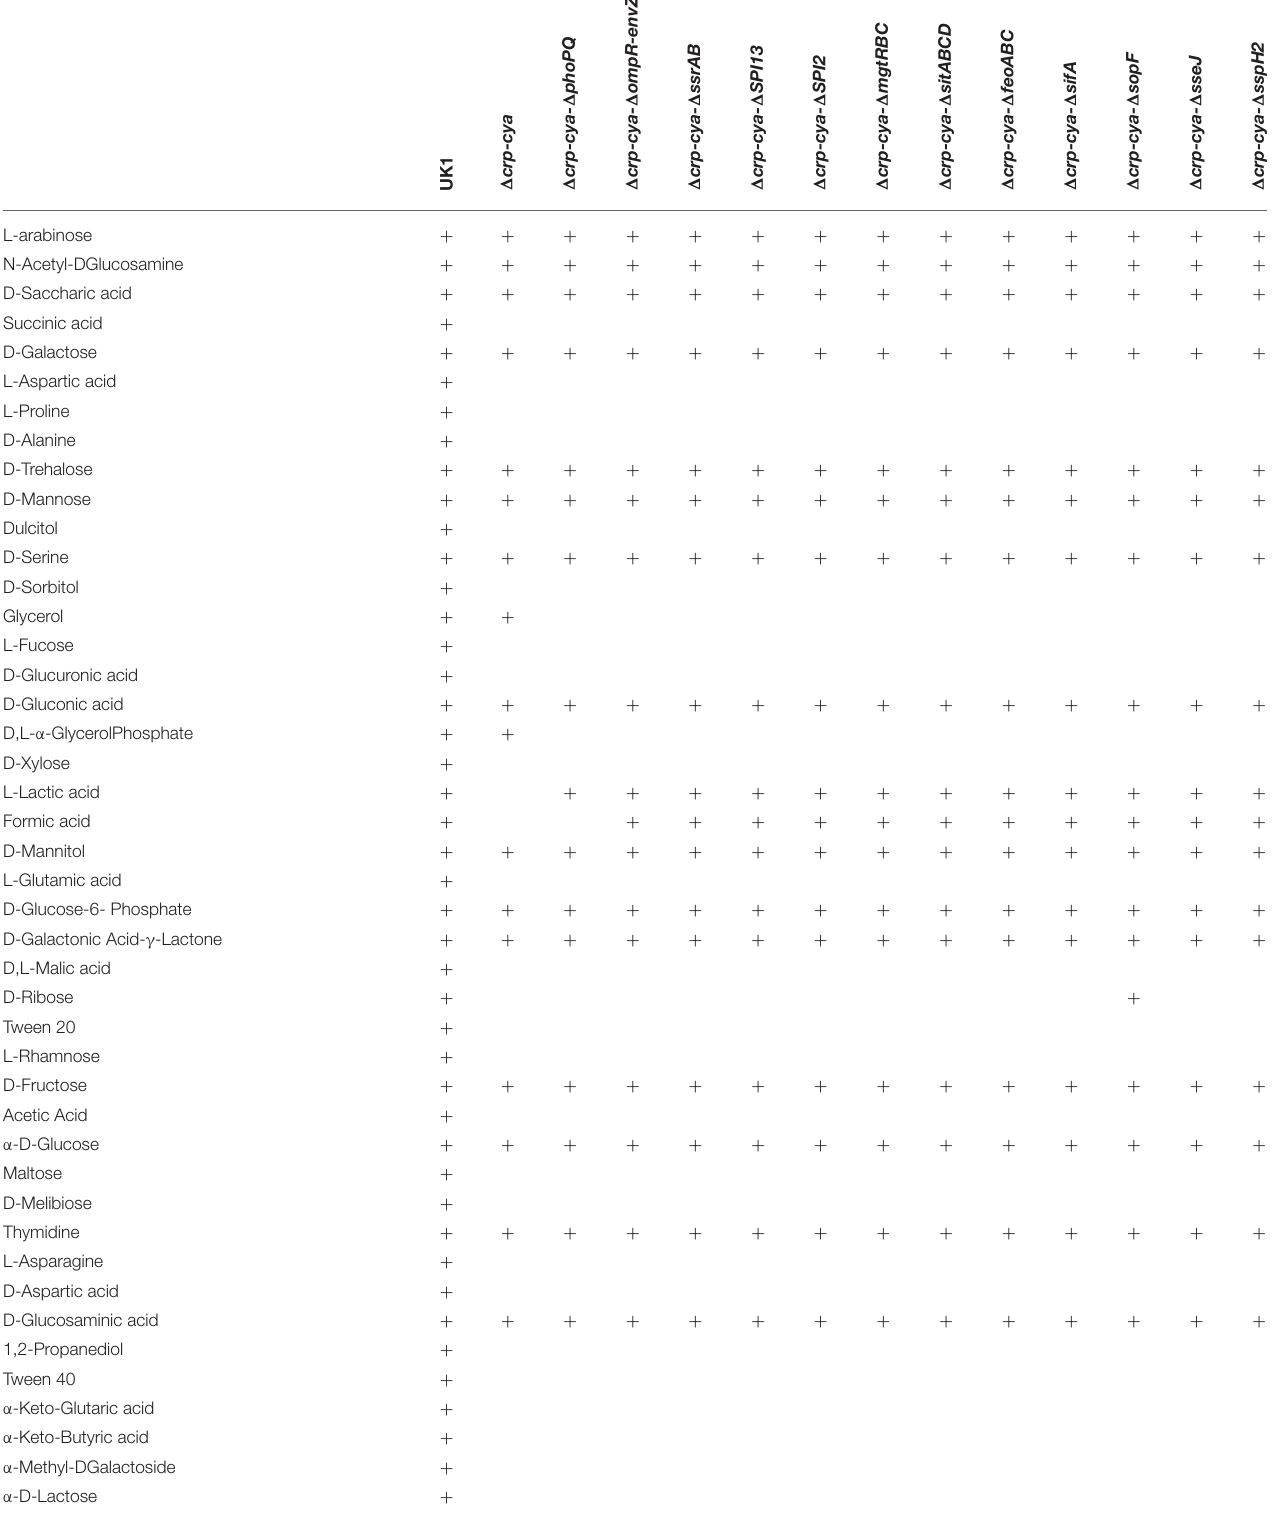
TABLE 2 | Carbon substrate utilization of Salmonella Typhimurium, the 1 crp - cya mutant and its